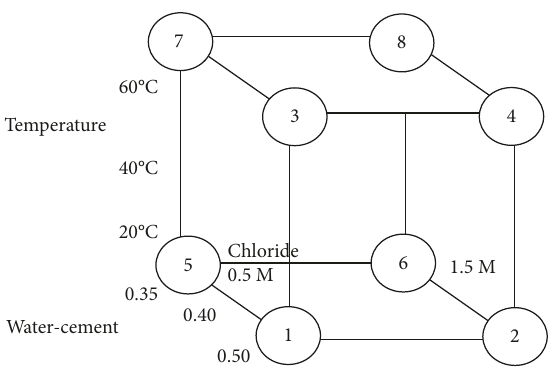
Figure 6: Schema of the factorial design of experiments: 2 3 factorial design.